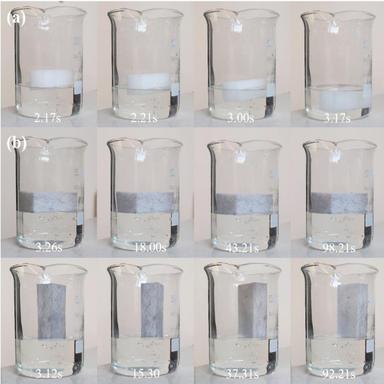
Water repellent test of absorbent sponge (a) before and (b) after superhydrophobic treatment.